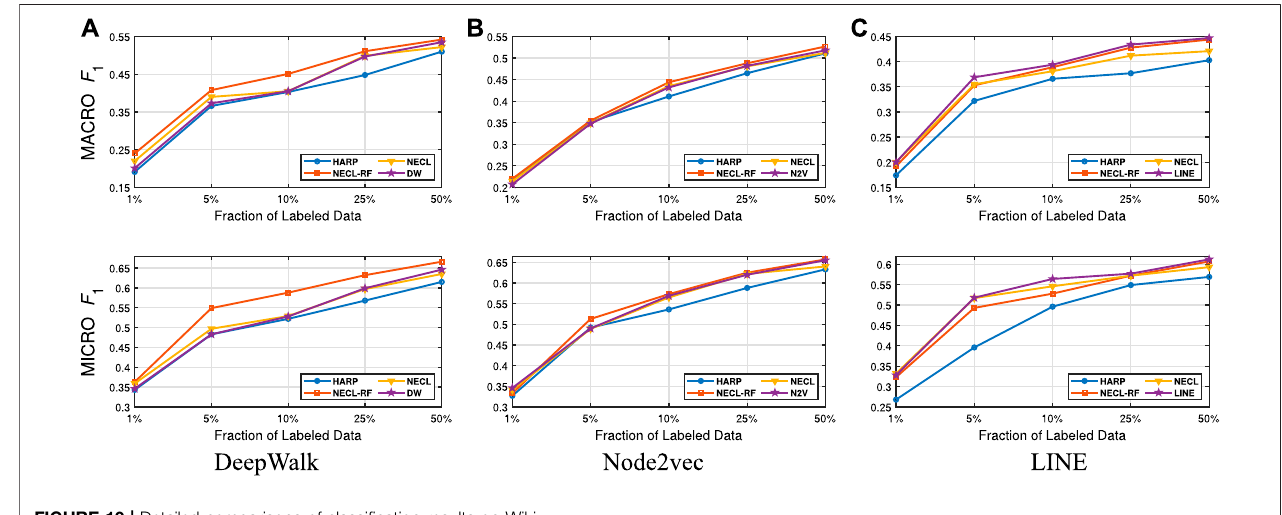
FIGURE 10 | Detailed comparisons of classi fi cation results on Wiki.